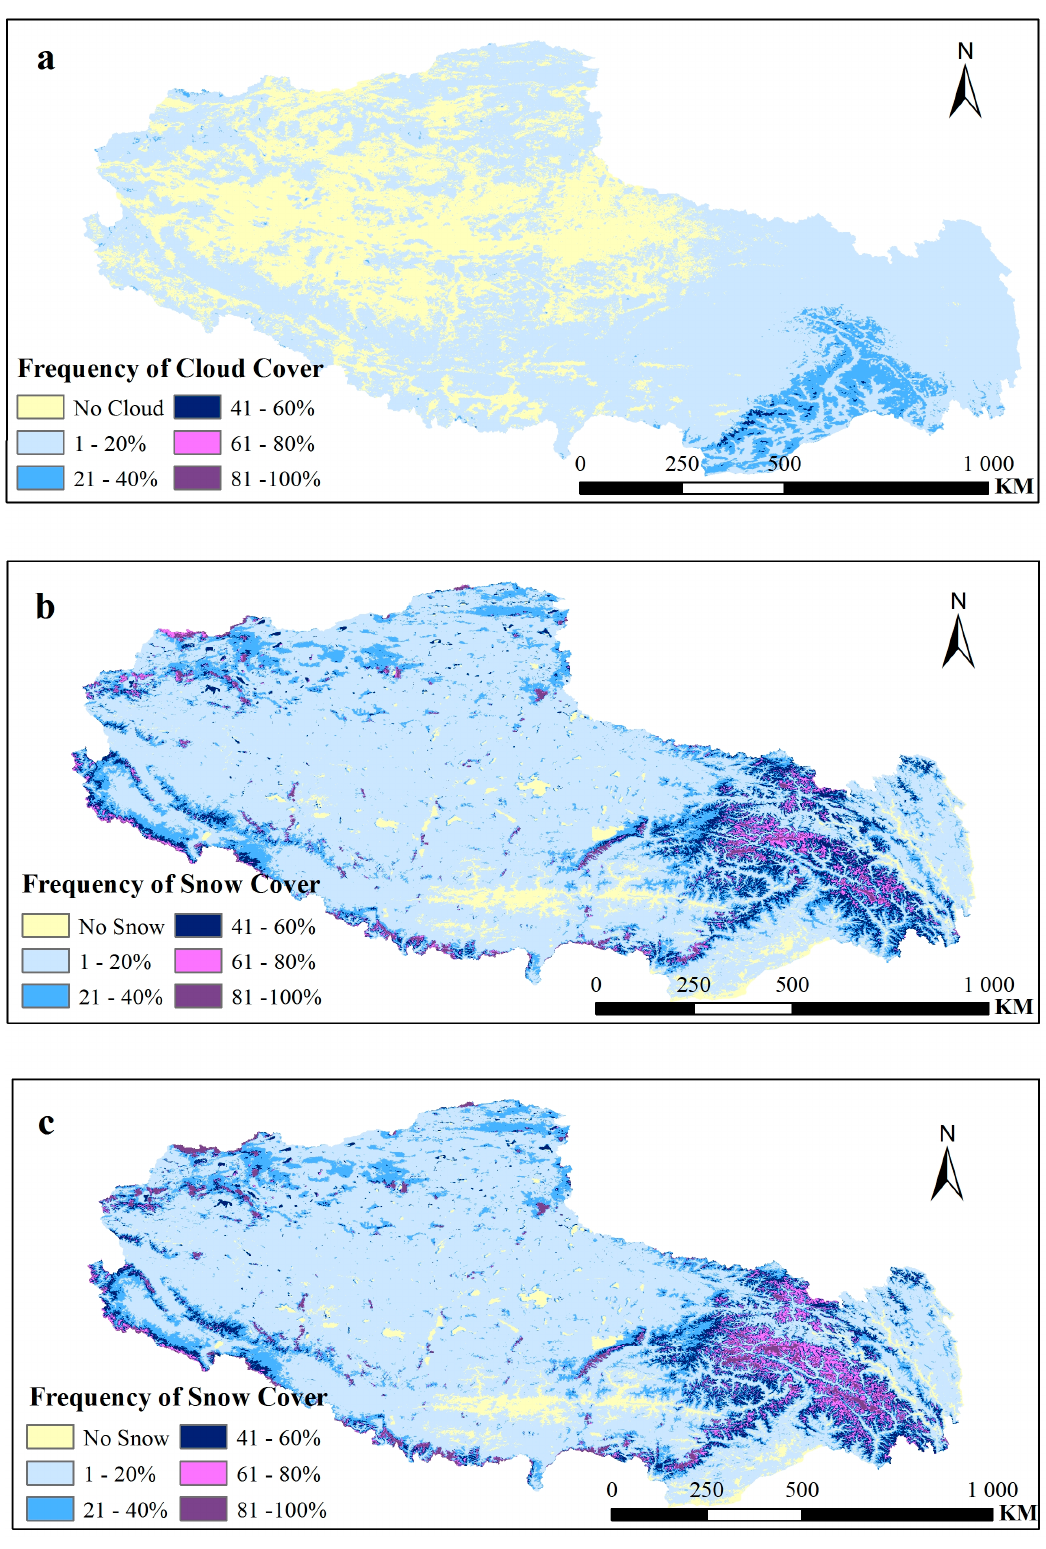
Figure 2. Spatial distribution of frequency ranges during the years 2001–2015 for ( a ) persistent cloud cover, ( b ) snow cover and ( c ) corrected snow cover.